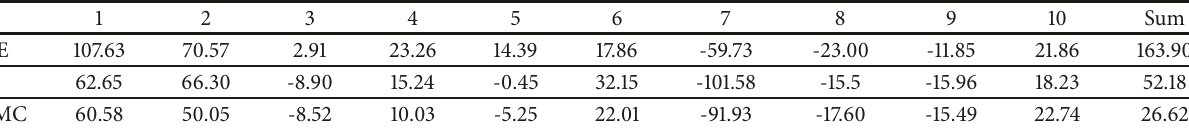
Table 3: Longtime portfolio returns on the IHYE and MV models, and the MCMC method.